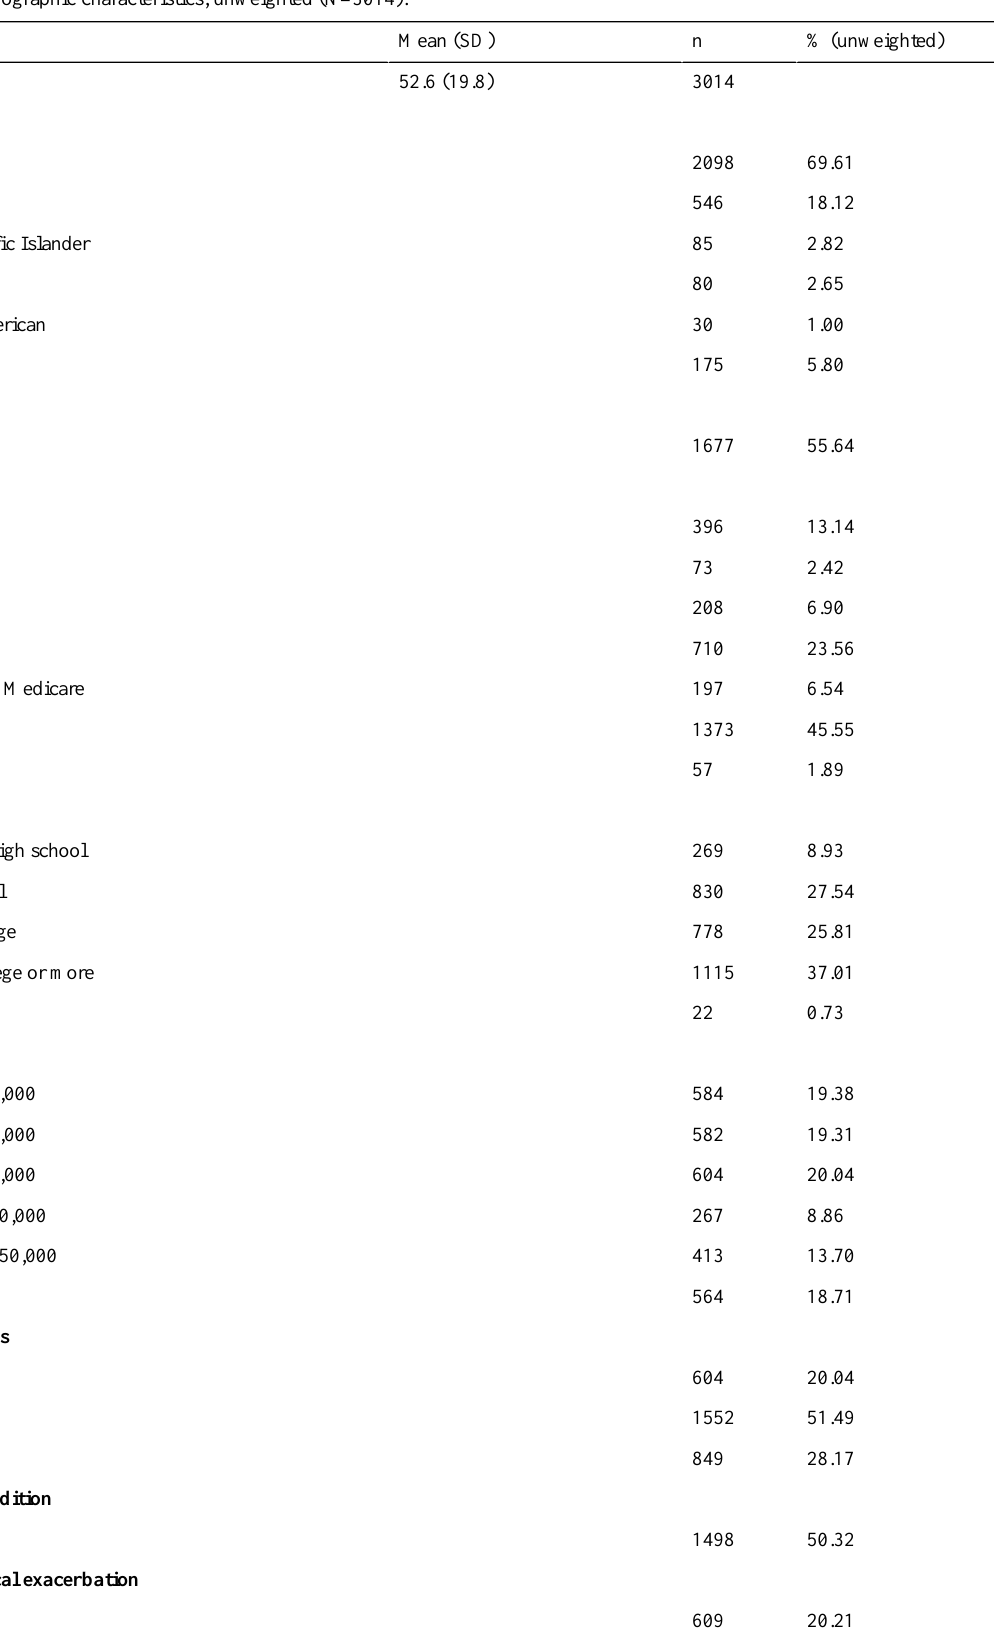
Table 1. Demographic characteristics, unweighted